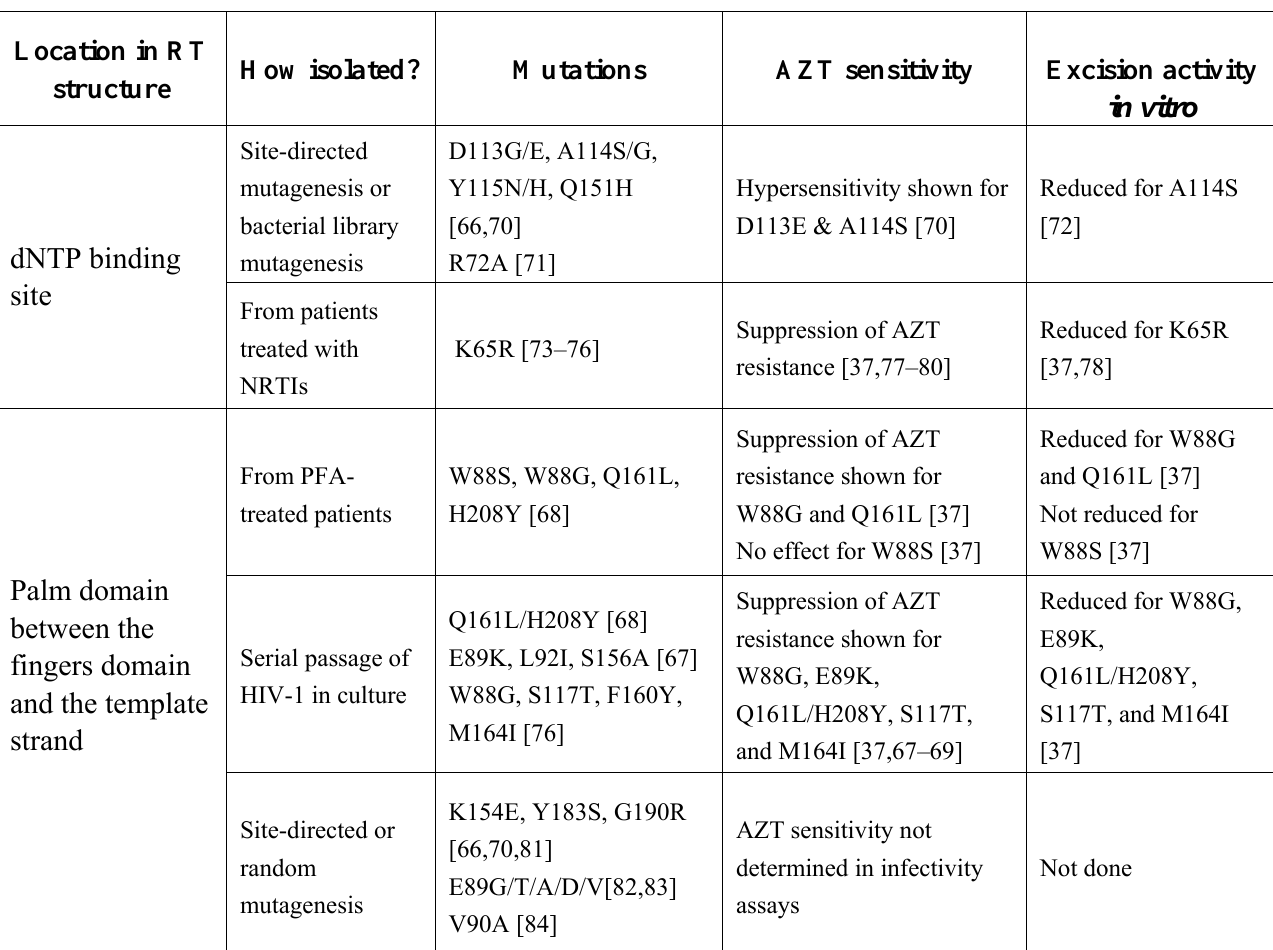
Table 2. PFA-resistant mutants of HIV-1